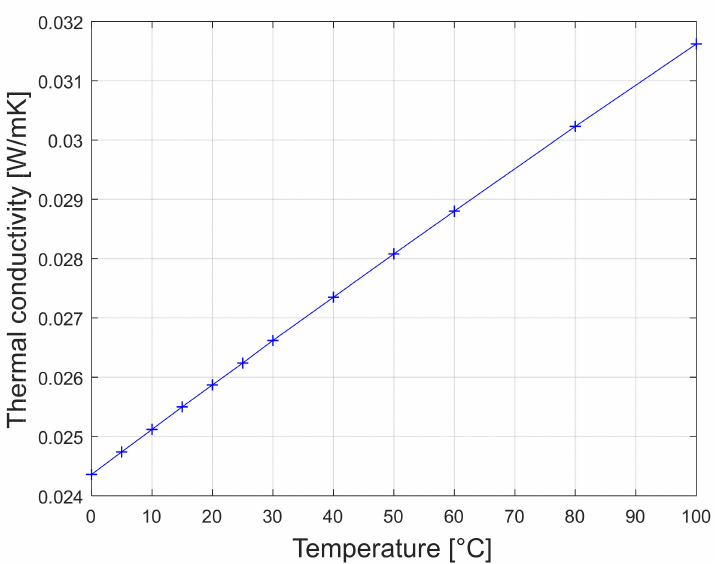
Figure 8. Temperature dependence of the thermal conductivity of air, using the data obtained from literature